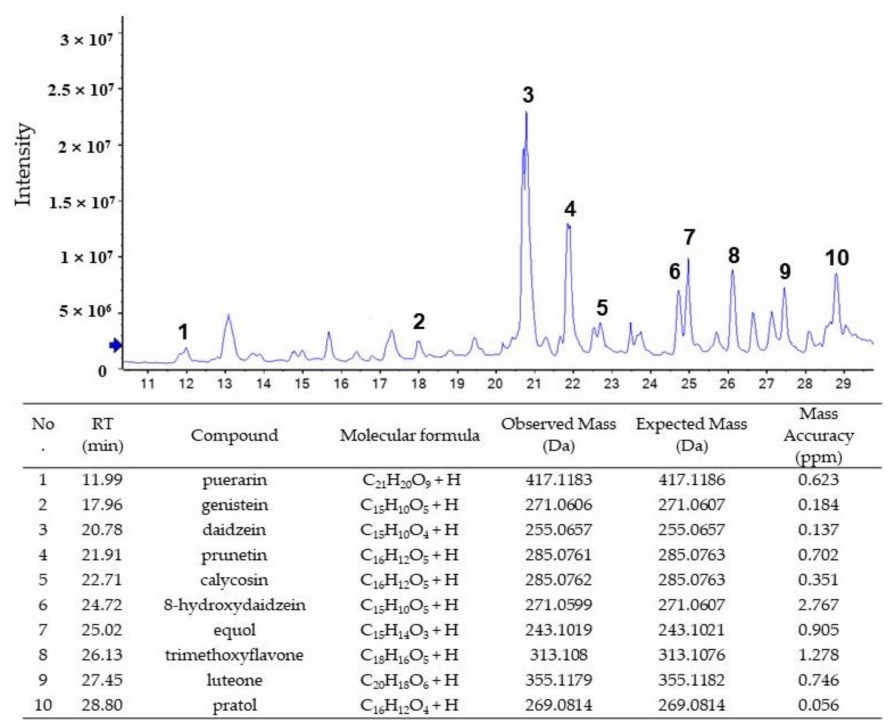
Figure 1. HPLC-QTOF/MS chromatograms of FPE, and mass data in total ion chromatograms (TIC) scan mode. Analysis was carried out on a Kinetex F5 C18 column (2.6 µ m, 2.1 × 100 mm) with gradient elution using solvents A (0.1% formic acid in water) and B (0.1% formic acid in acetonitrile). The elution gradients were as follows: 0–6 min, B 5%; 6–8 min, B 5–15%; 8–16 min, B 15–20%; 16–27 min, B 20–30%; 27–32 min, B 30–100%; and 30–34 min, B 100%. The flow rate was 300 µ L/min, and the injection volume was 10 µ L for each run. Mass detector settings were as follows: cone voltage 40 V; capillary 3.0 kV; source temperature 500 ◦ C; cone gas flow 30 L/h; and desolvation gas flow at 800 L/h. The peaks of 1–10 were identified to be 10